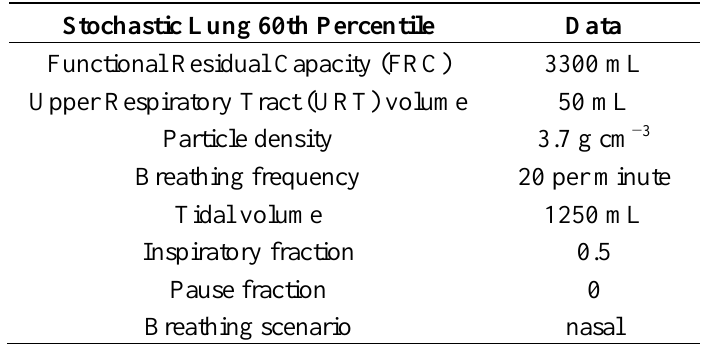
Table 1. Multiple-Path Particle Dosimetry (MPPD) model parameters.